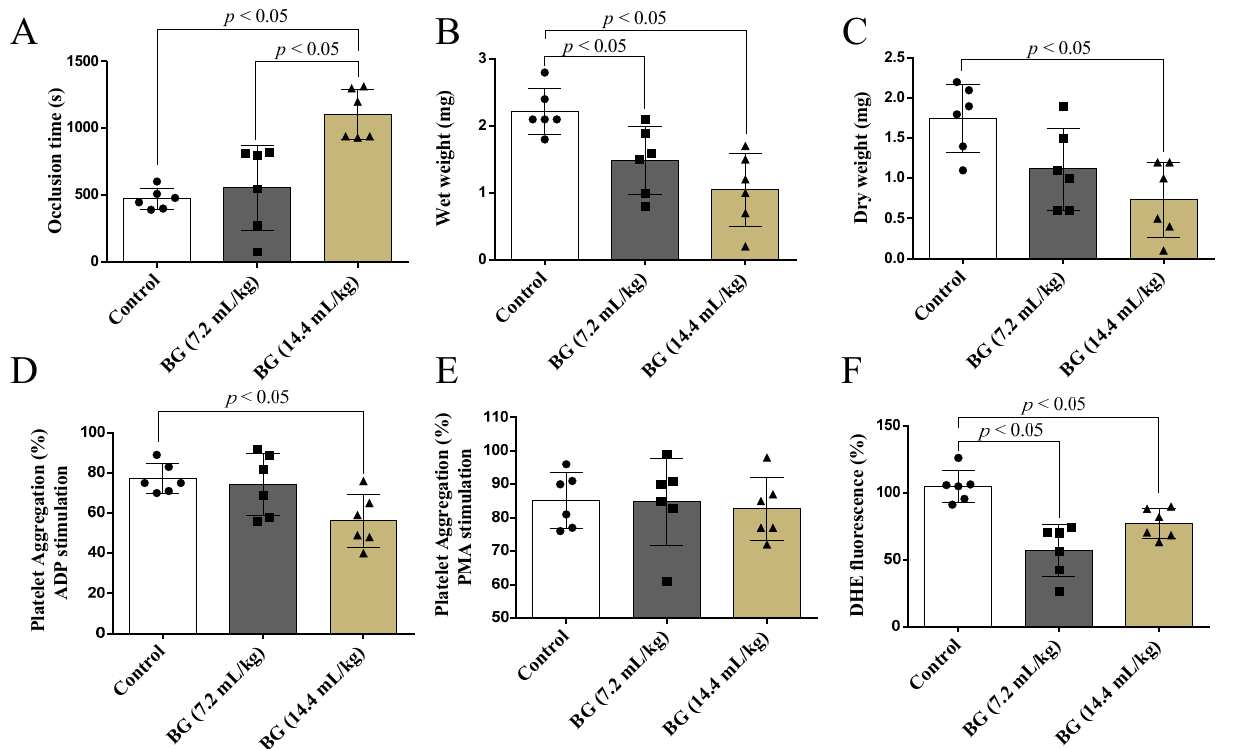
Figure 2. Effects of Baru almond oil ( Dipteryx alata Vog. ) on platelet aggregation, thrombus formation, and reactive oxygen species in male rats. Assessment of occlusion time ( A ), wet weight of thrombus ( B ), dry weight of thrombus ( C ), ADP-induced platelet aggregation ( D ), PMA-induced platelet aggregation ( E ), and DHE fluoresce in platelet ( F ) in male rats. Groups: control group (control), Baru group receiving 7.2 mL/kg of Baru almond oil (BG, 7.2 mL/Kg), and Baru group receiving 14.4 mL/kg of Baru almond oil (BG, 14.4 mL/Kg). Data are presented as mean ± standard deviation and analyzed by ANOVA one-way test with Tukey as a post-hoc test.